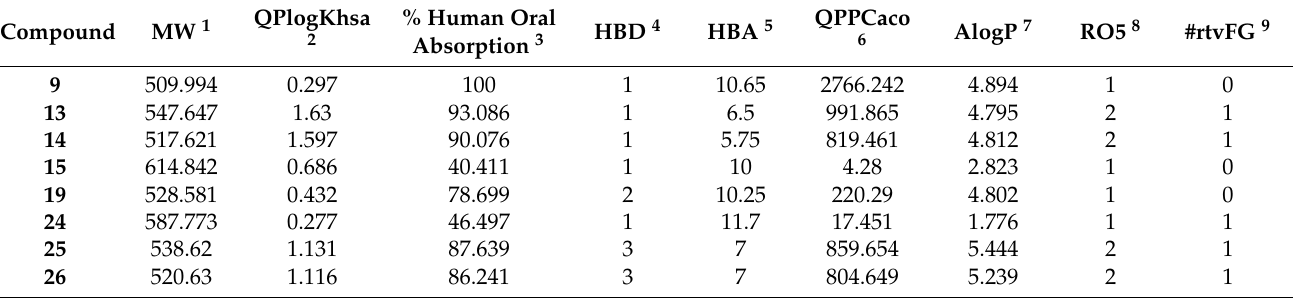
Table 2. Calculated physicochemical and ADMET properties of the active virtual screening hit